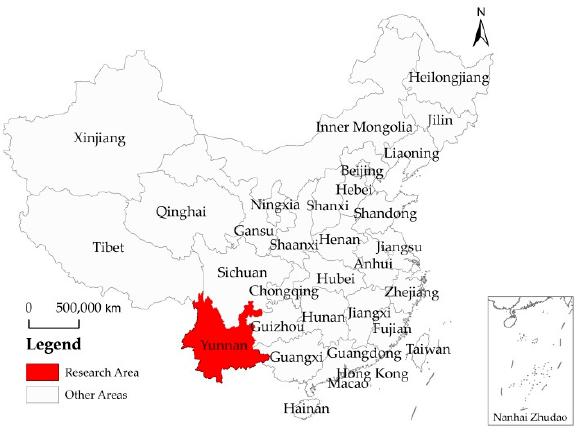
Figure 1. Geographic Position of Research Area.